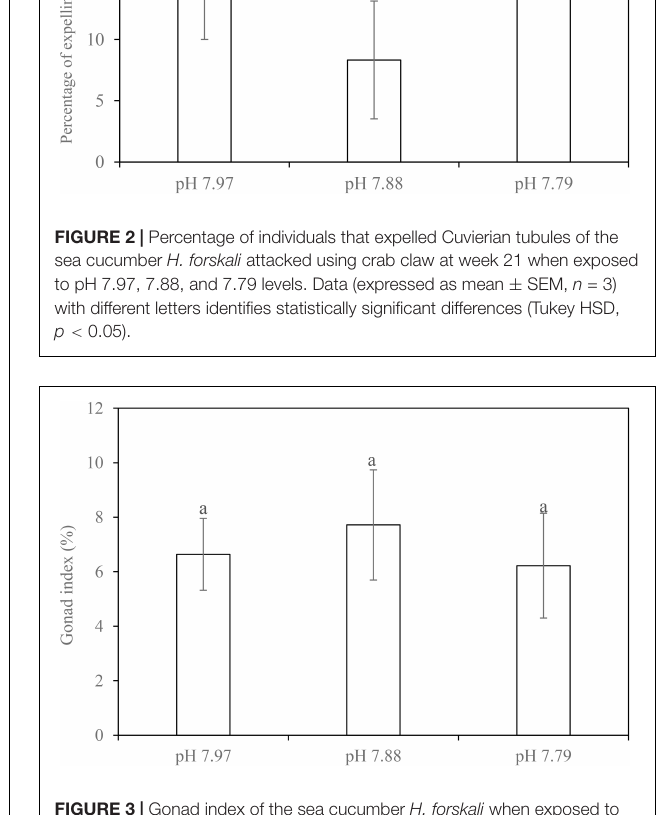
FIGURE 3 | Gonad index of the sea cucumber H. forskali when exposed to pH 7.97, 7.88 and 7.79 levels for 22 weeks. Data (expressed as mean ± SEM, n = 12) with different letters identifies statistically significant differences (Tukey HSD, p < 0.05). Four types of ossicles, namely, rods ( Figures 4A,E,I ), table ( Figure 4D ), button ( Figure 4H ), and disk ( Figure 4L ), were observed from the SEM images. Ossicles extracted